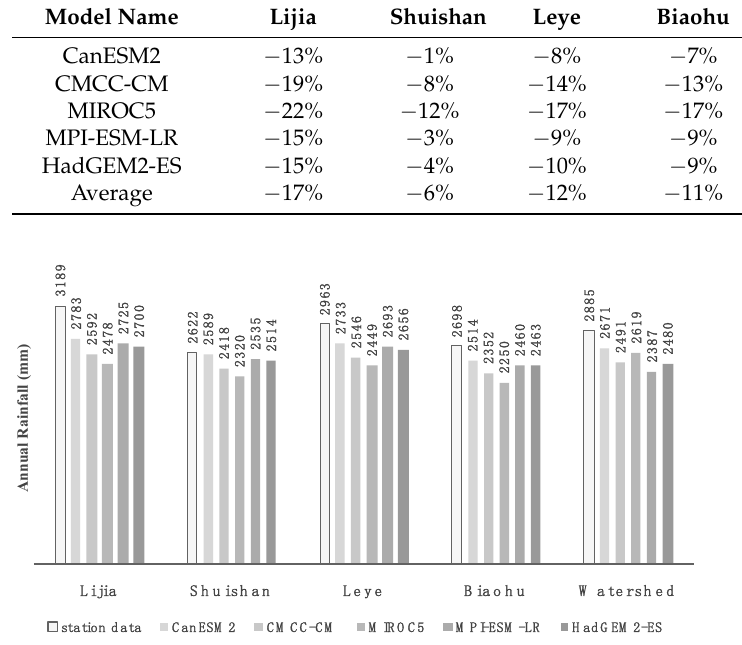
Figure 5. Annual rainfall of the station data and GCM data.